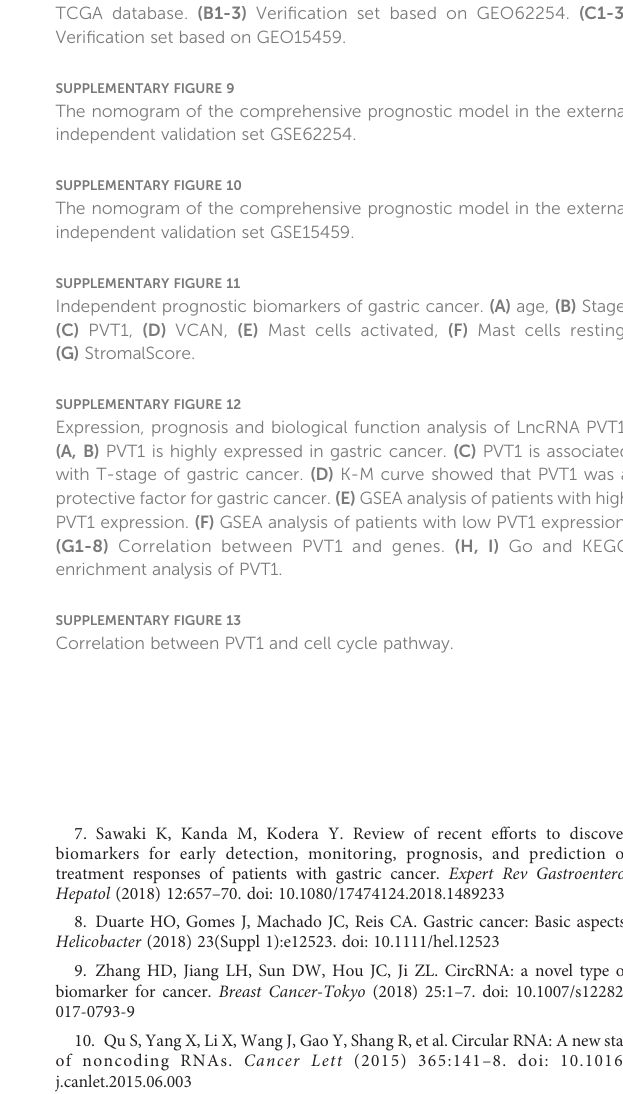
SUPPLEMENTARY FIGURE 7 Lasso regression analysis. (A) Use the minimum criterion of 10 times cross validation to select adjustment parameters in lasso regression. (B) Characteristic curve of lasso coef fi cient.